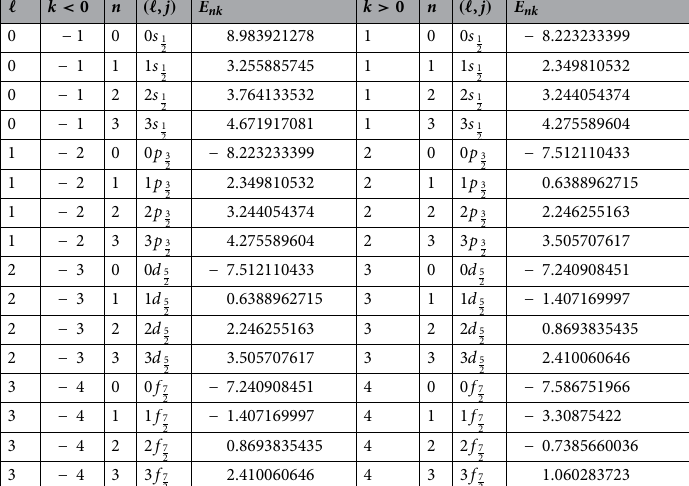
0.1, M 10 fm − 1 , ( (cid:31) = =